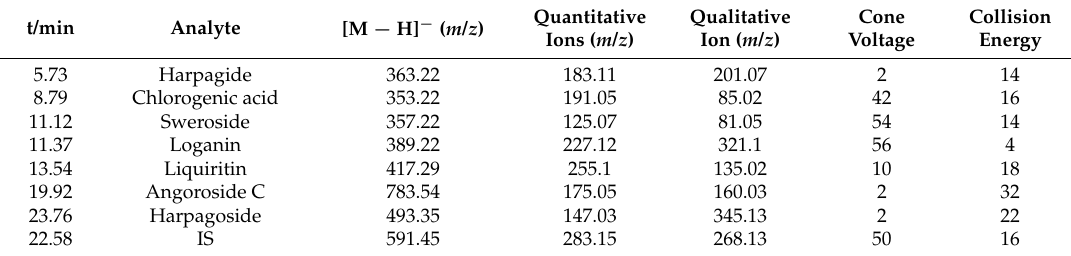
Table 1. Ultra-performance liquid chromatography-tandem mass spectrum (UPLC-MS/MS) transitions and parameters for the detection of the analytes and internal standard (IS).